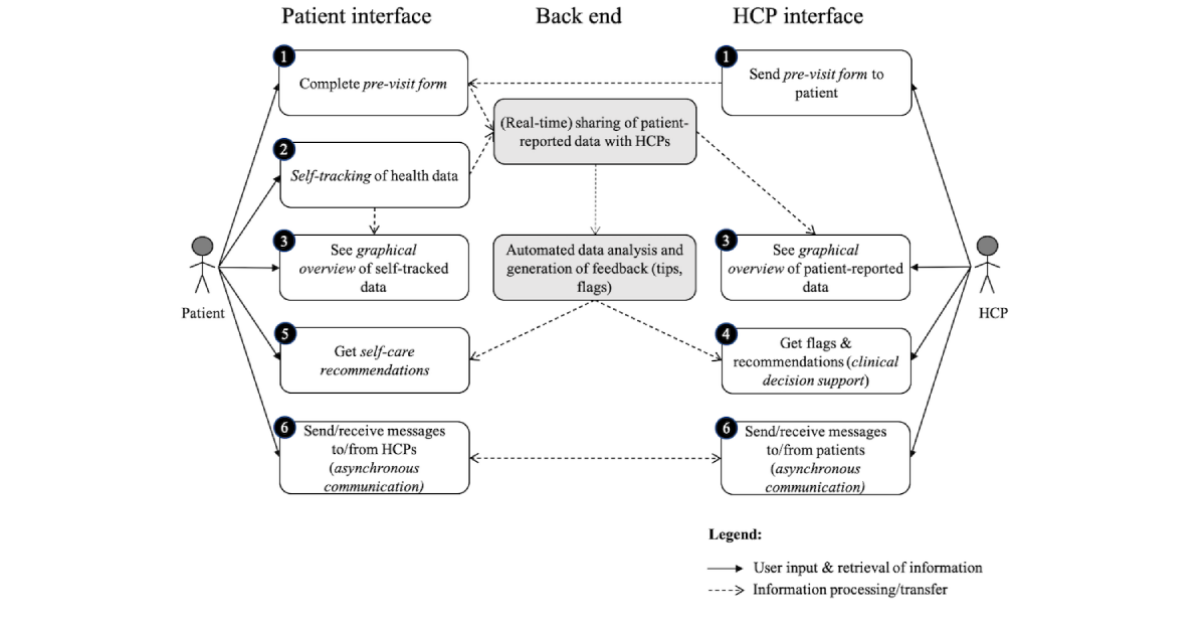
Figure 2. Use case diagram describing the desired functionalities of an eHealth service to support co-care in Parkinson’s disease care management, targeting the patient (left) and health care professionals (HCPs; right). The numbers in circles refer to the numbered eHealth functionalities in the text.